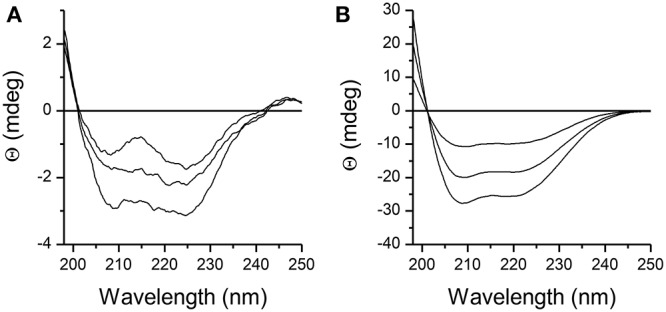
CD spectra of the peptide DPcpvtN2. (A) 1.5, 2.0, and 3.0 μM solution of DPcpvtN2 in phosphate buffer, pH 7.0. (B) 1.5, 2.0, and 3.0 μM solution of DPcpvtN2 in ethanol.